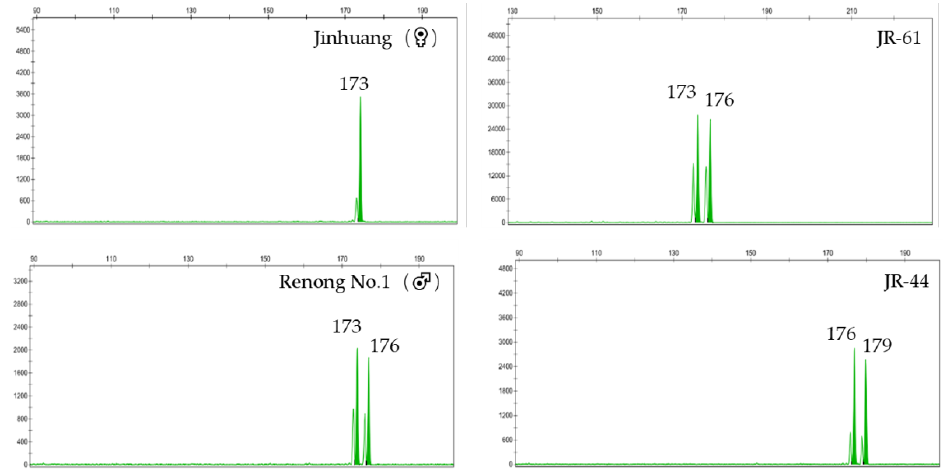
Figure 3. Capillary electrophoresis results obtained with ES63 in ‘Jinhuang’, ‘Renong No.1’, true hybrid JR-61, and false hybrid JR-44.